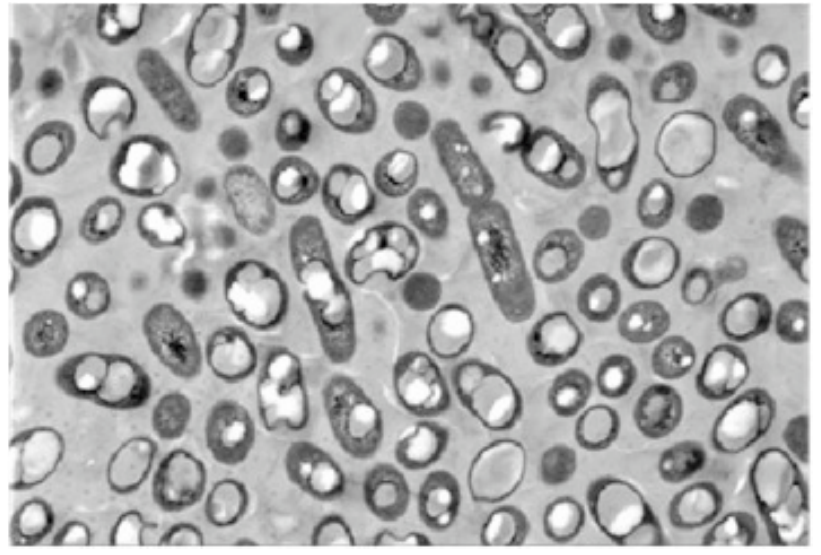
Figure 3. Microscopic image of PHA granules [82].